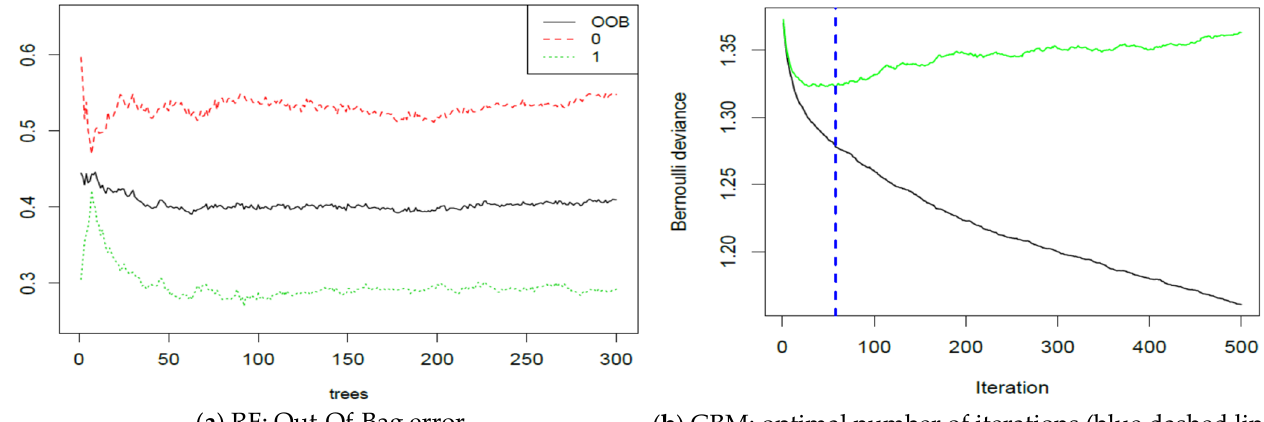
Figure 2. Random forest (RF) and gradient boosting machine (GBM) performance. Table 2. Confusion matrix.